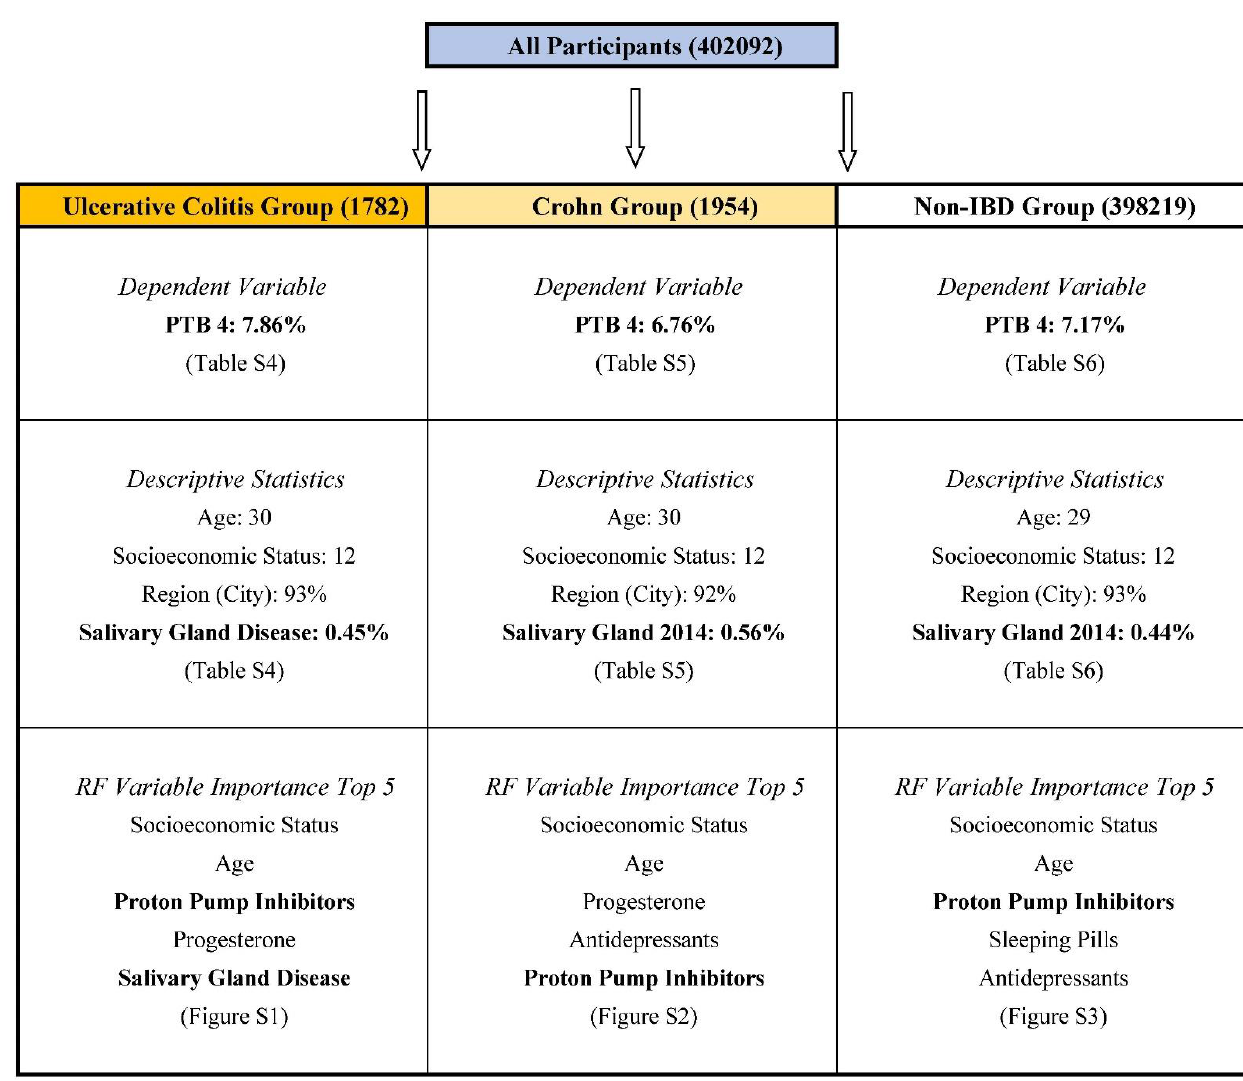
Figure 1. Summary of Results. Important variables are highlighted as bold. The proportion of preterm birth was higher for the Ulcerative Colitis (UC) Group and the Non-Inflammatory-Bowel-Disease (Non-IBD) Group than for the Crohn Group: 7.86%, 7.17% vs. 6.76%. Based on random forest variable importance, salivary gland disease was a top 10 determinant for the prediction of preterm birth for the UC Group, but it was not the case for the Crohn Group or the Non-IBD Group. The top 5 variables of preterm birth for the UC Group during 2015–2017 were socioeconomic status (8.58), age (8.00), proton pump inhibitors (2.35), progesterone (2.13) and salivary gland disease in 2014 (1.72). Note: IBD Inflammatory Bowel Disease, PTB Preterm Birth, RF Random Forest.